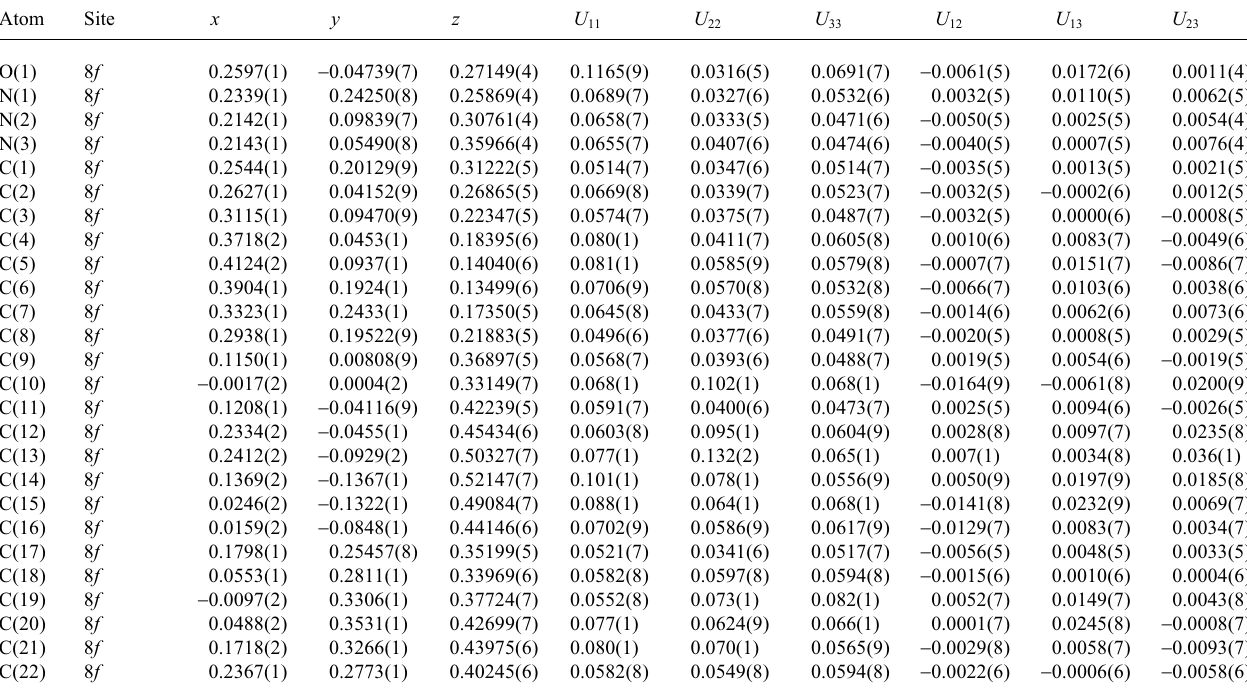
Table 3. Atomic coordinates and displacement parameters (in Å 2 )